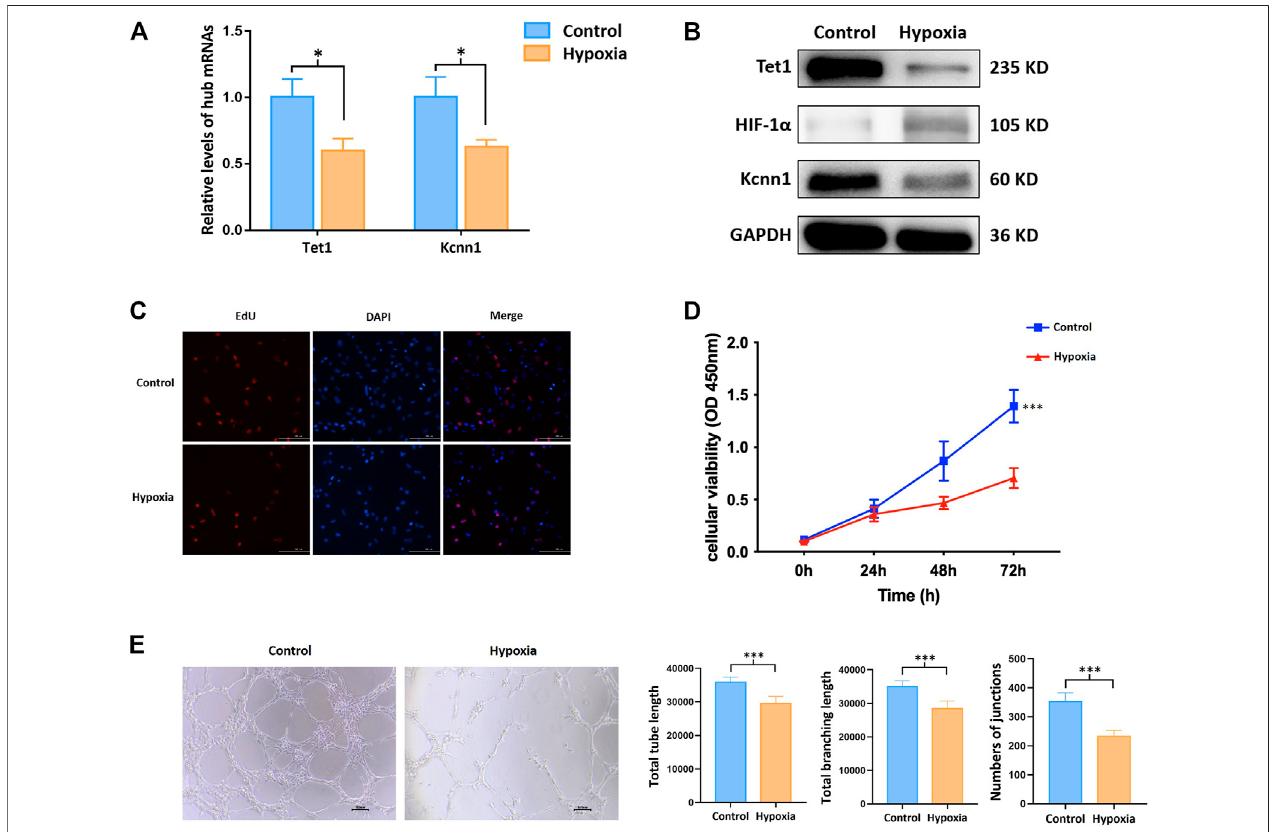
FIGURE 6 | m 6 A methylation regulated hub mRNAs play a role on angiogenesis in vitro . (A) Expression of angiogenesis related mRNAs by qRT-PCR; (B) protein level of Tet1, Kcnn1, and HIF-1 α by Western blot; (C) cell proliferation by EdU assay; (D) cell viability by CCK-8 assay; (E) tube formation. * p < 0.05; *** p < 0.001.